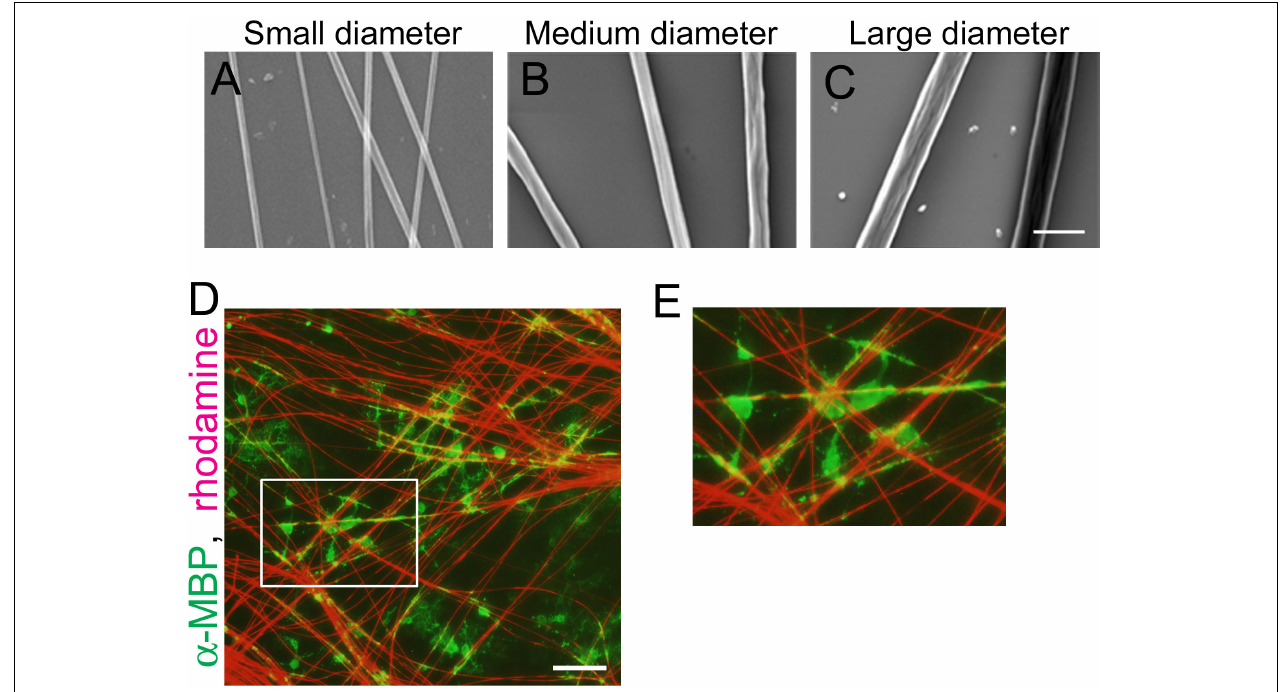
FIGURE 1 | OLs can ensheath polystyrene nanofibers similarly to live axons. (A–C) Phase contrast images of polystyrene nanofibers with diameters ranging 0.55–0.9 µ m [ (A) , small diameter], 1.5–1.7 µ m [ (B) , medium diameter] and 2.5–4.0 µ m [ (C) , large diameter]. Scale bar, 5 µ m. (D) Fluorescent image of MBP (a mature OL marker, green) and sulforhodamine (red), labeling polystyrene nanofibers after 7 days in vitro . Scale bar, 100 µ m. (E) Magnified images of (D) , showing OL cells ensheathing